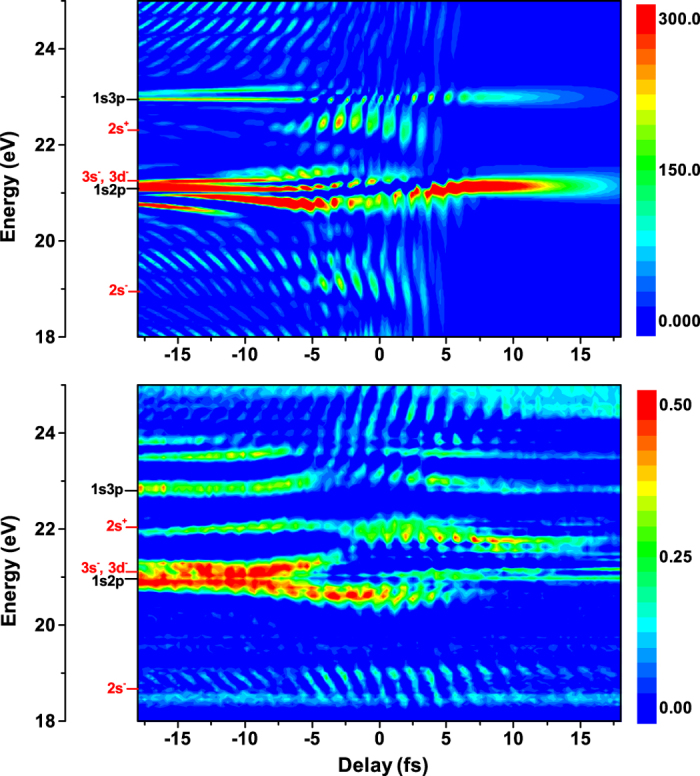
Time-delay-dependent absorbance spectrum of helium with a dressing infrared laser, where comparisons have been made between numerical results (upper) and experimental data18 (lower).Here, the time delay is between the dressing laser pulse (ωd = 1.7 eV, Id = 1013 W/cm2, FWHM duration of 6 fs) and the attosecond pulse (ωXUV = 22.5 eV , IXUV = 1012 W/cm2 and FWHM duration of 100 as).